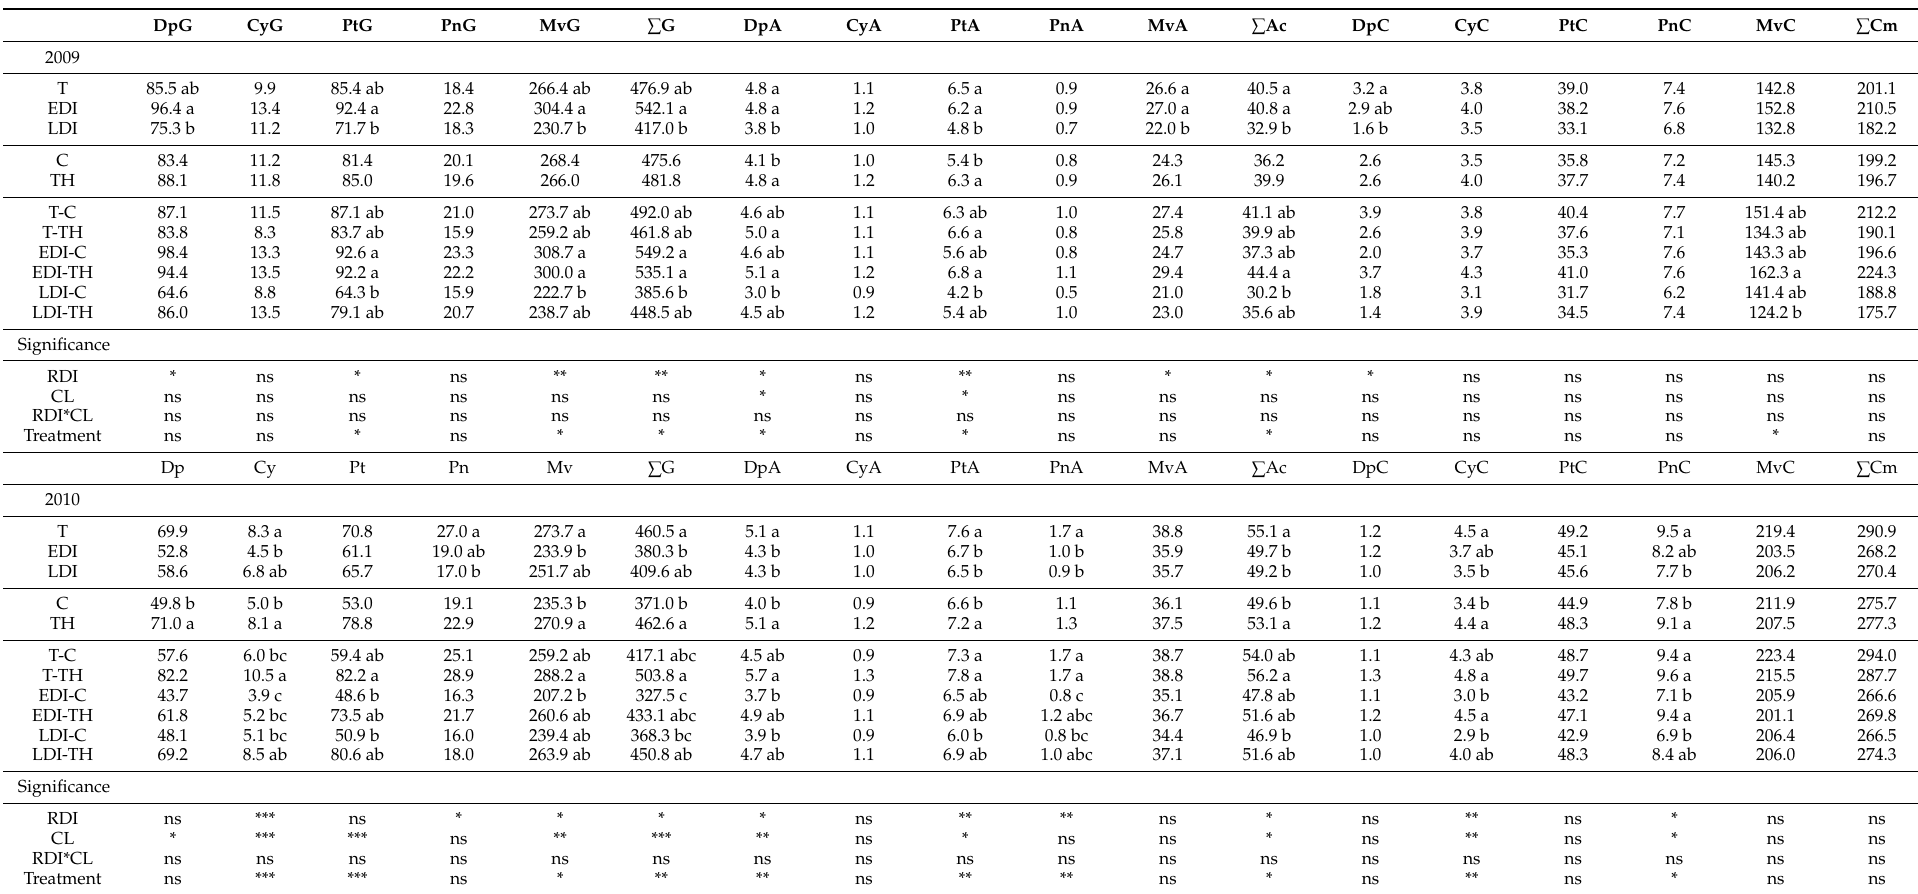
Table 1. Effects of regulated deficit irrigation and cluster thinning on grape skin anthocyanin concentration (mg/kg berry fresh weight) in 2009 and